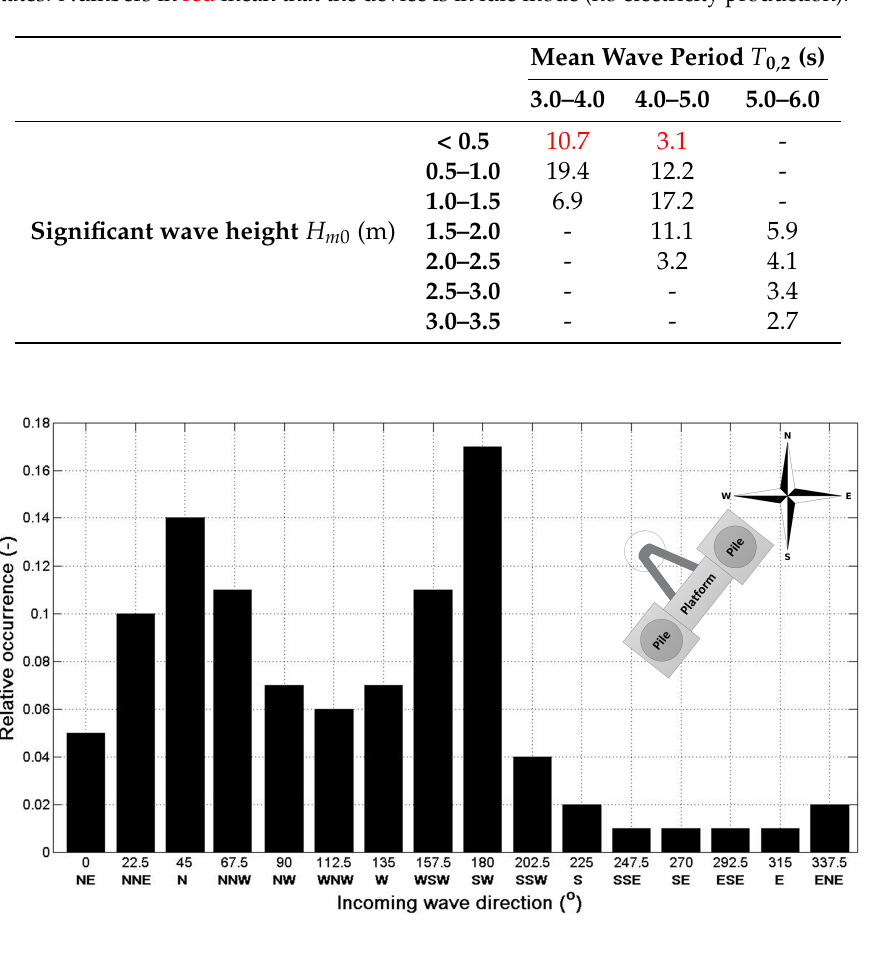
Table 2. Scatter diagram with the probabilities of occurrence (given here in percent) of the different wave states. Numbers in red mean that the device is in idle mode (no electricity production).